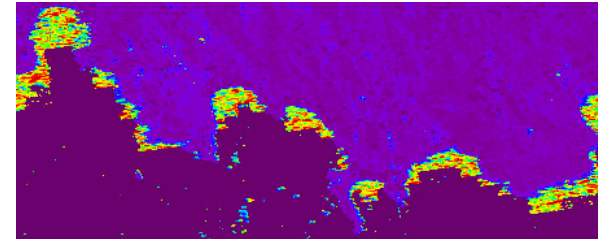
Figure 8. Psarrou study site. Height error map created using TANDEM-X IDEM metadata, c (cid:13) DLR 2014.